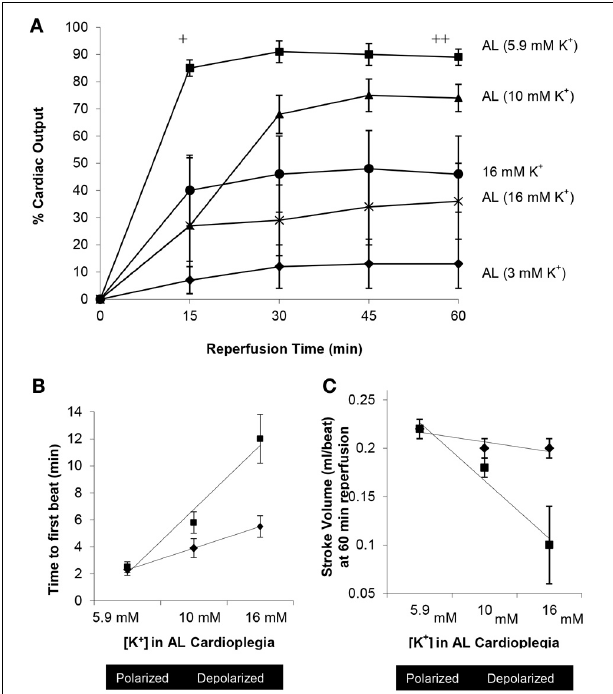
FIGURE 8 | Effect of increasing extracellular potassium in AL cardioplegia on return of cardiac output, time to first beat and stroke volume after 1 and 2h arrest at 32–33 ◦ C in the isolated working rat heart [Adapted from Sloots and Dobson (2010)]. (A) Percentage recovery of cardiac output in following 2h arrest at 32–33 ◦ C. + AL (5.9mM K + ) p < 0 . 01 (One-Way analysis of variance) compared with AL (3, 10, 16mM K + ) and 16mM K + alone. ++ AL (5.9mM K + ) p < 0 . 01 (One-Way analysis of variance) compared with AL (3mM K + ); p < 0 . 05 (repeated measures) compared with AL (3,16mM K + ) and 16mM K + alone. ∗ AL (10mM K + ) p < 0 . 01 (repeated measures) compared with AL (3mM K + ). (B) Relationship between the time to first beat at reanimation after 1 or 2h arrest and the concentration of potassium in AL cardioplegia solution (5.9, 10, and 16mM K + ). (C) Relationship between stroke volume and